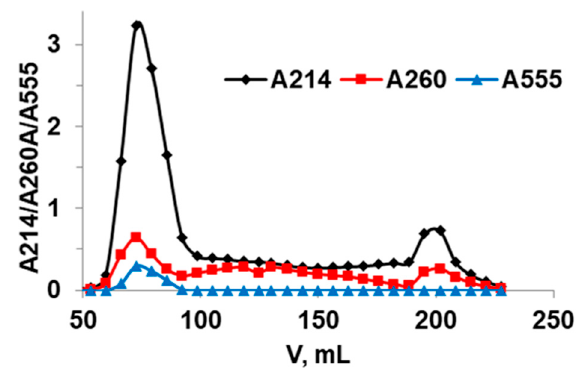
Figure 4. Elution profile obtained by gel filtration on Sephadex G-200 of commercial mucin.